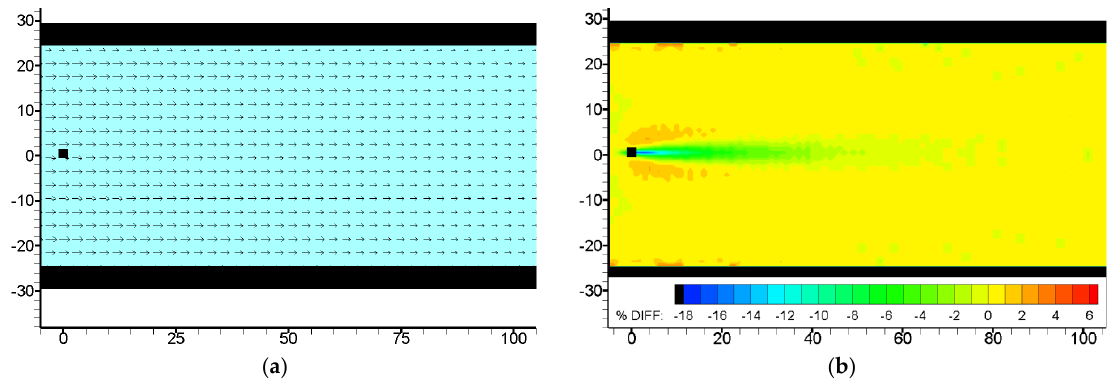
Figure 5. ( a ) Current velocity vectors and ( b ) percentage change in current speeds at mid ‐ flood for a single turbine (Note: in ( a ) vectors are only shown at every fourth grid cell).